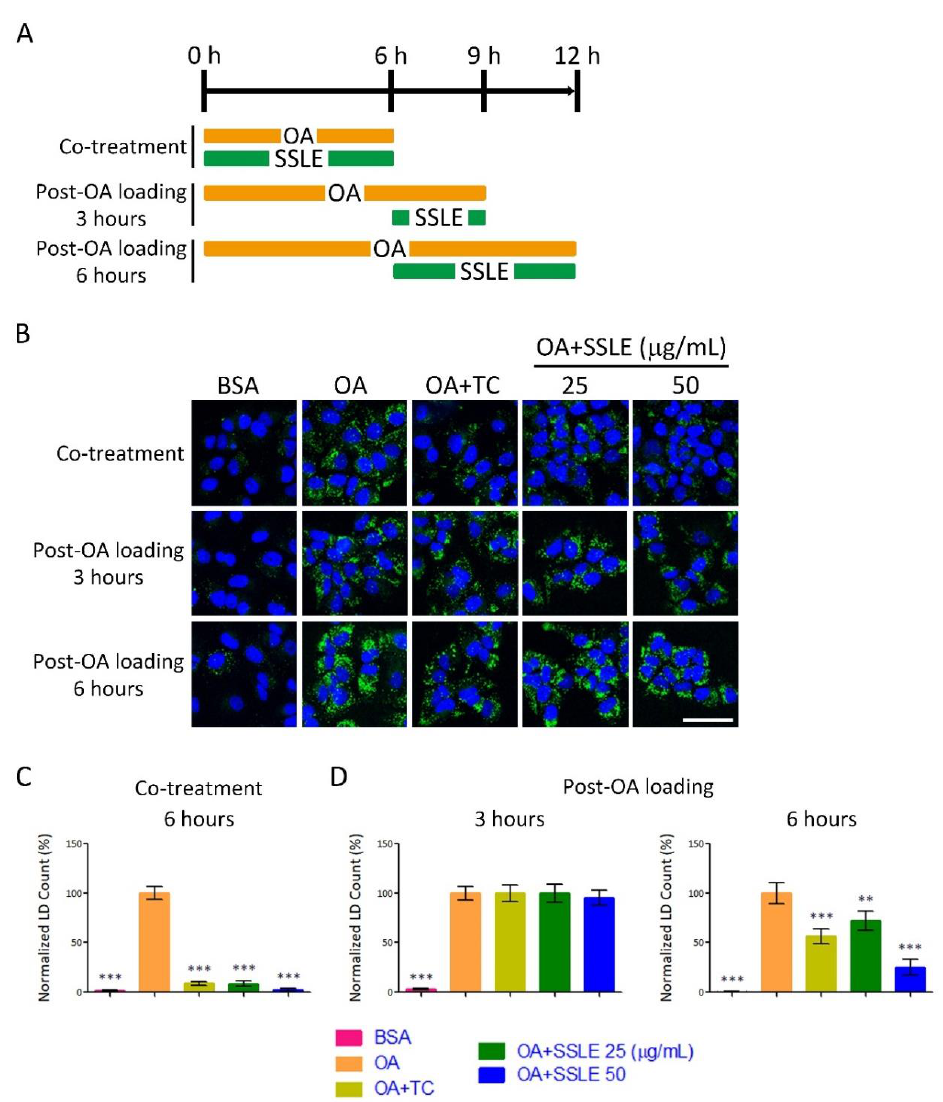
1 µ M TC for 6 h (co-treatment protocol) or treated with 125 µ M OA for 6 h to allow LD formation, then loading protocol). ( B ) Representative images. Bar: 50 µ m. The quantification results of the